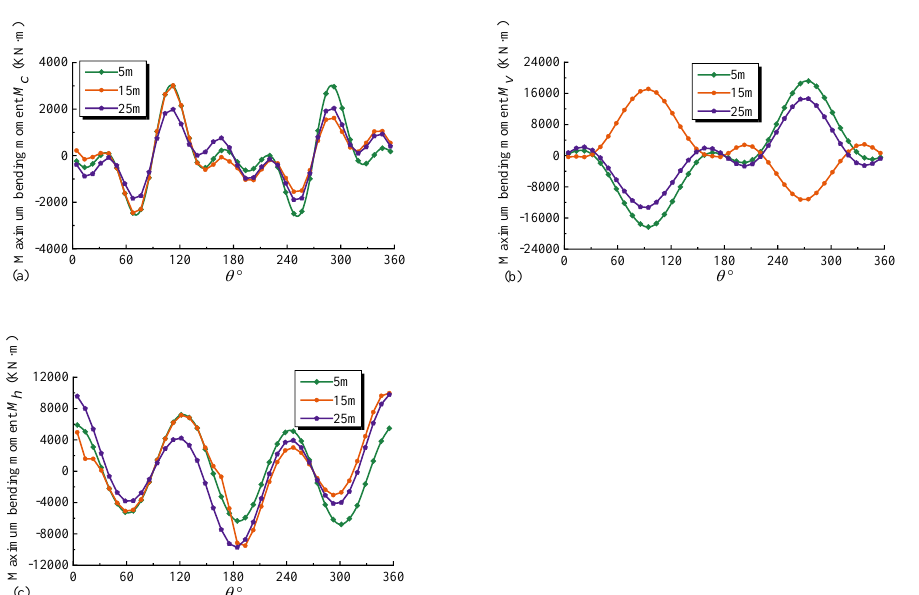
Figure 15. The maximum bending moment ( a ) M c , ( b ) M v and ( c ) M h of tunnel lining at different soil–rock interfaces when P wave is incident.